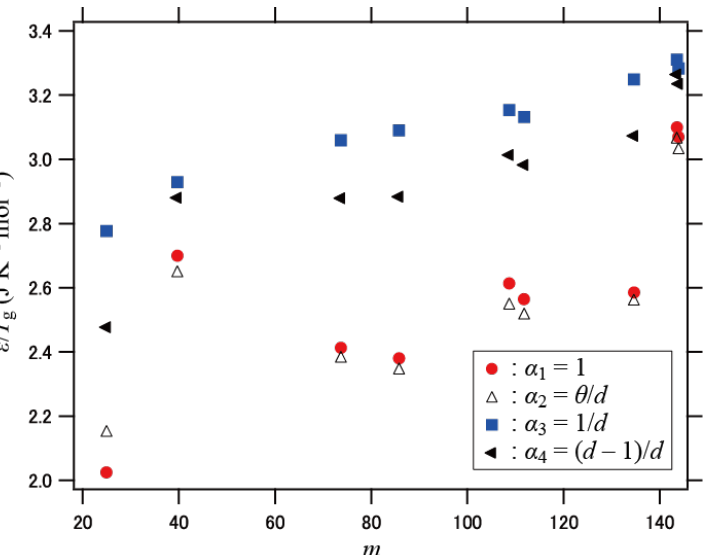
Figure 7. Plots of ε / T g vs. m for the four different assumptions for the exponent α